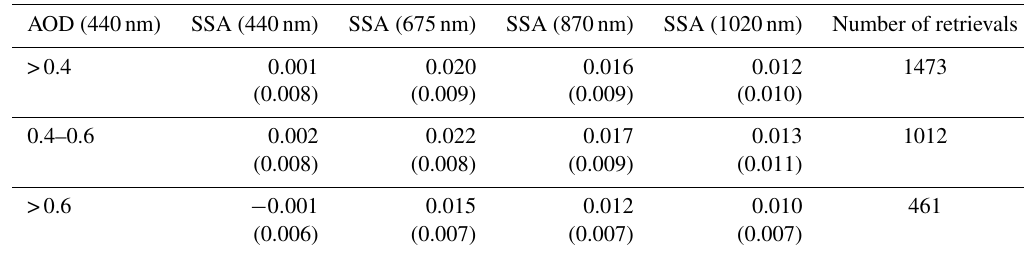
Table 1. Statistics, average values and standard deviations (in parentheses) of the difference in SSA retrievals from almucantar scans of V2 and V3 for the Mezaira site. The difference is defined as V3 − V2.